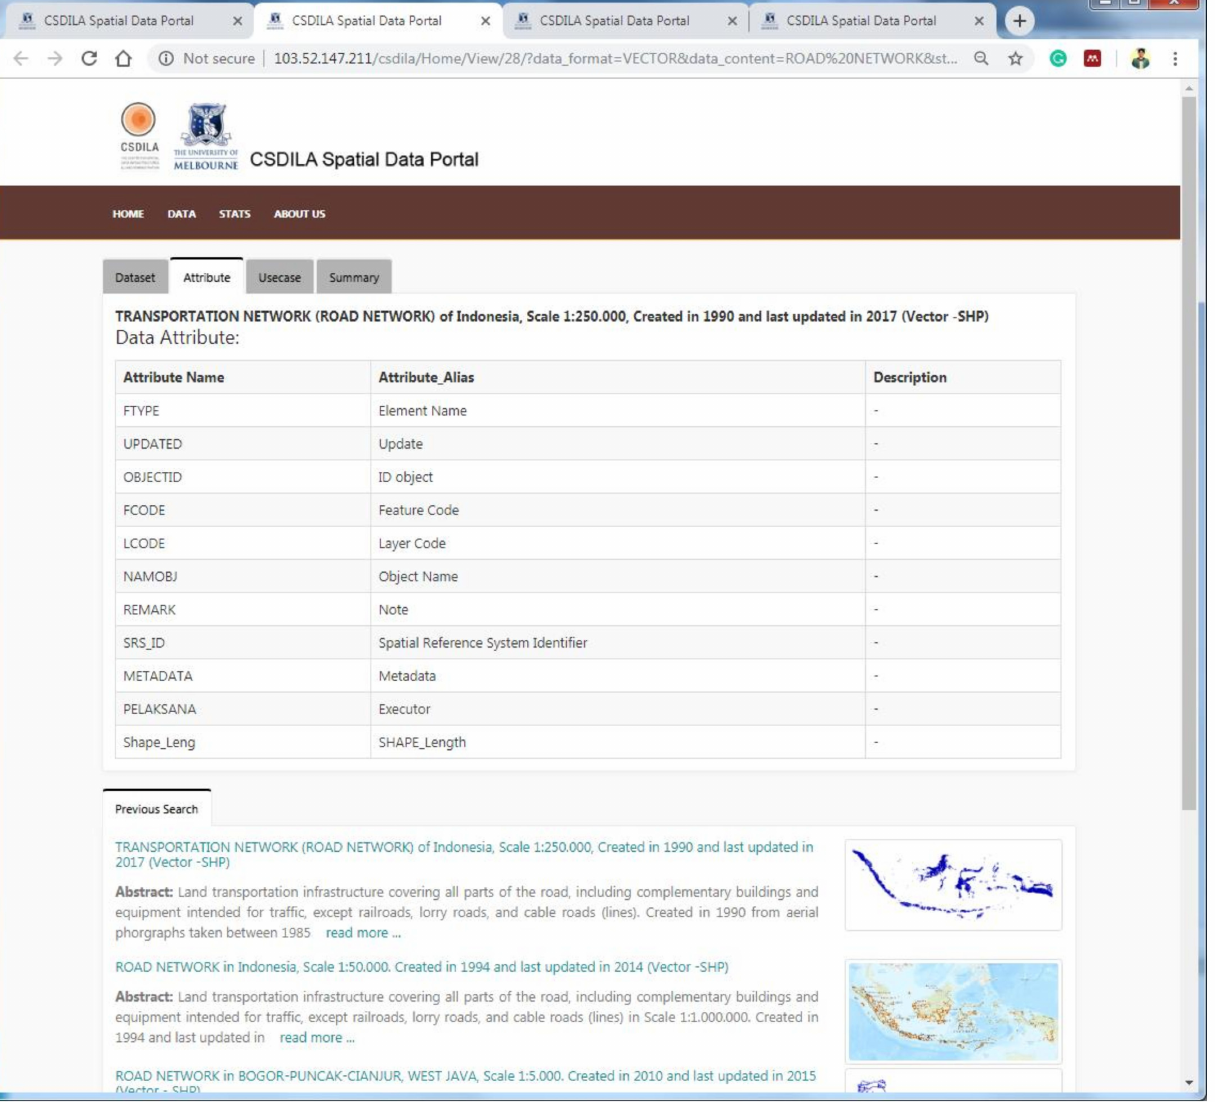
Figure 7. Metadata page (Attribute